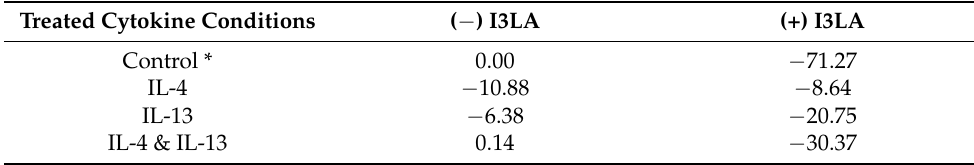
Figure 2. Contraction rate changes during incubation between group that was treated with I3LA ( ■ ) and group that was treated without I3LA ( ● ). ( a ) Control conditions; ( b ) IL-4 and IL-13 treatment; ( c ) IL-4 only treatment; ( d ) IL-13 only treatment. Table 1. Differences in contraction compared to control (%).